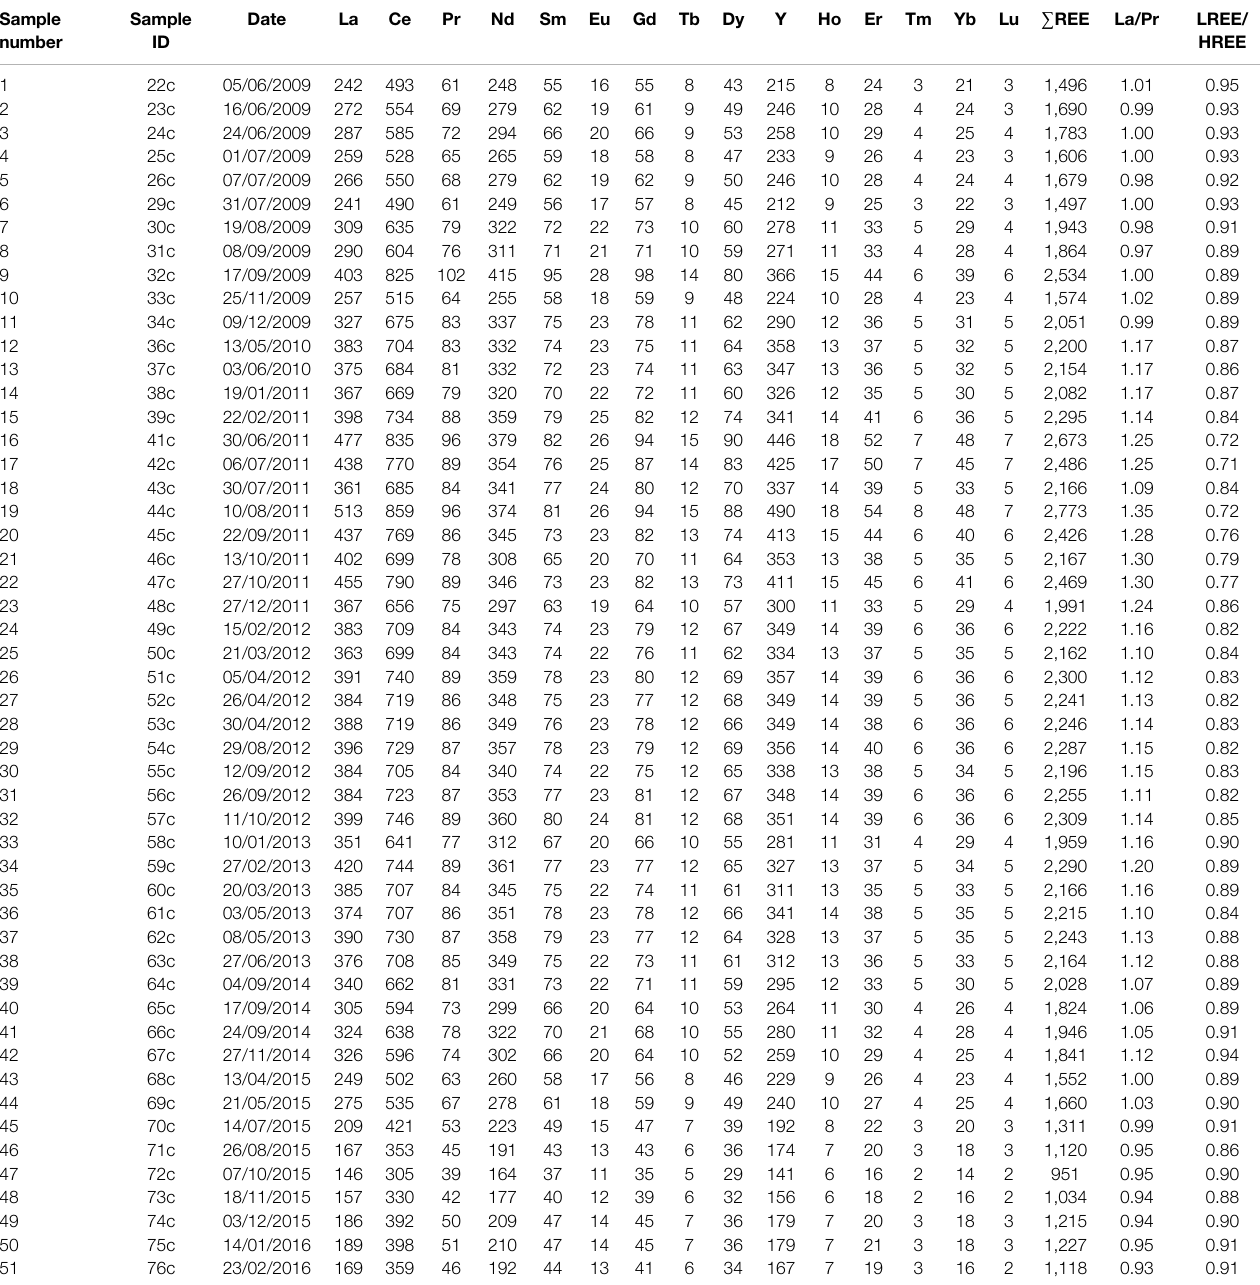
TABLE 2 | Rare Earth Elements concentrations (µg kg -1 ). La/Pr and LREE/HREE ratios are normalized to the average volcanic local rock (Carr et al., 2013). Sample